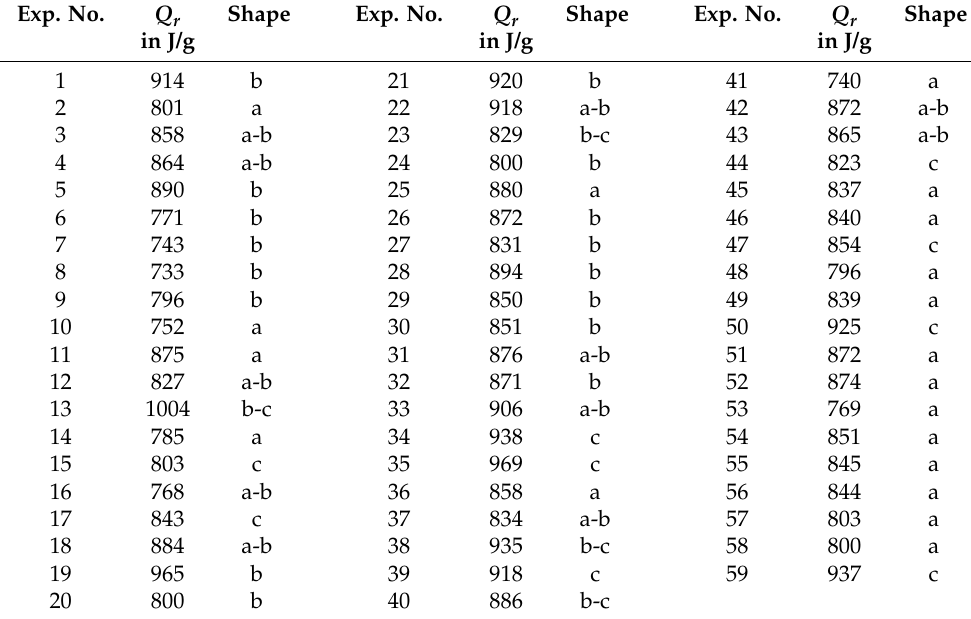
Table 1. Heat of reactions of the samples and assigned shapes of the measurement curve. Exp. No. Q r Shape Exp. No. Q r Exp.